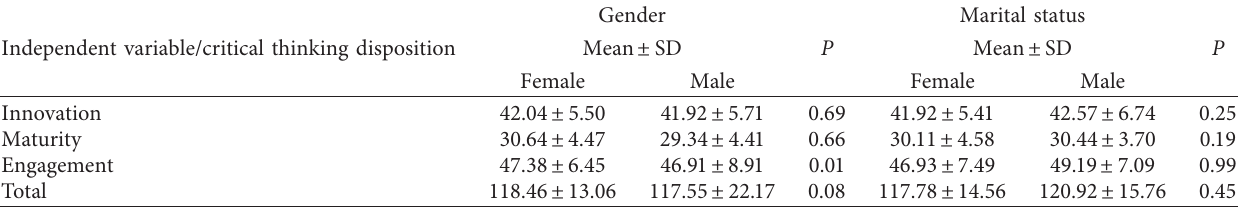
Table 2: Total score of critical thinking disposition and scores of its dimensions by gender and marital status.